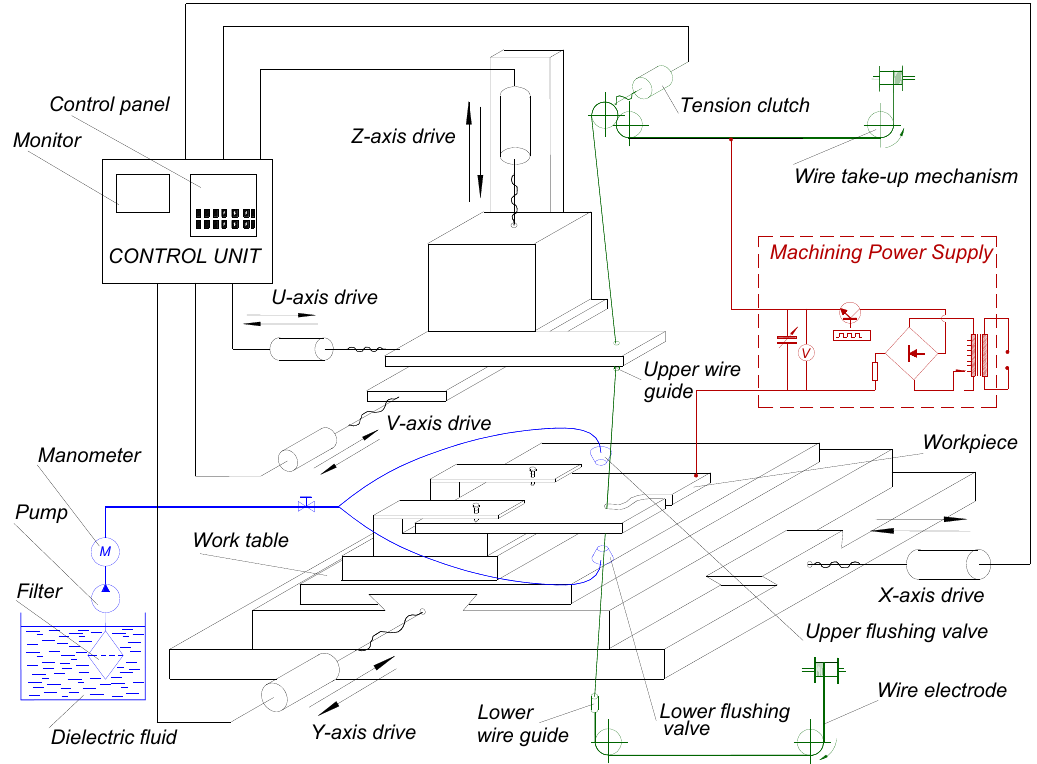
Figure 1. Schematic representation of the machining zone and the machining equipment in the case of the wire electrical discharge machining (WEDM) process.